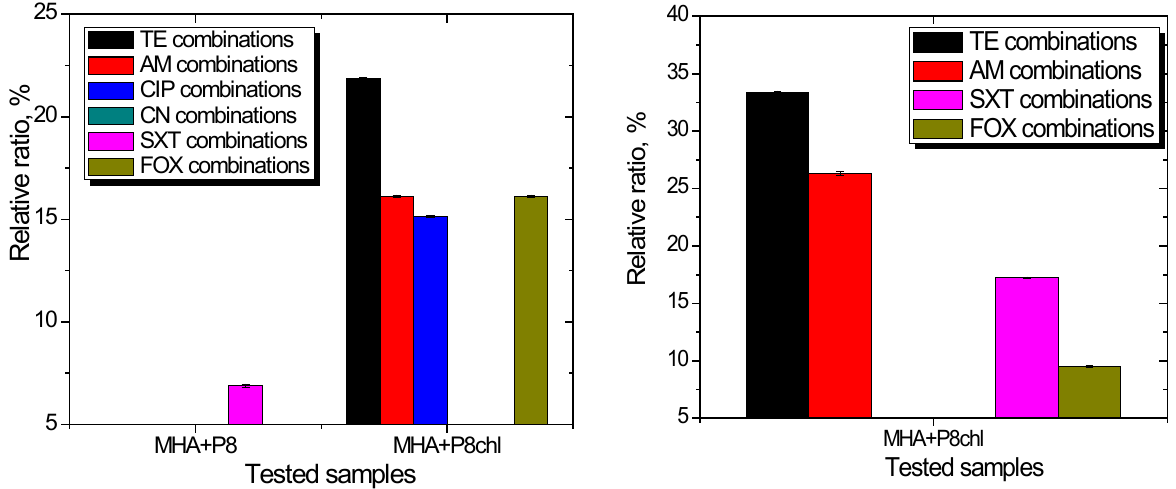
Figure 11: P. mirabilis ATCC 29245